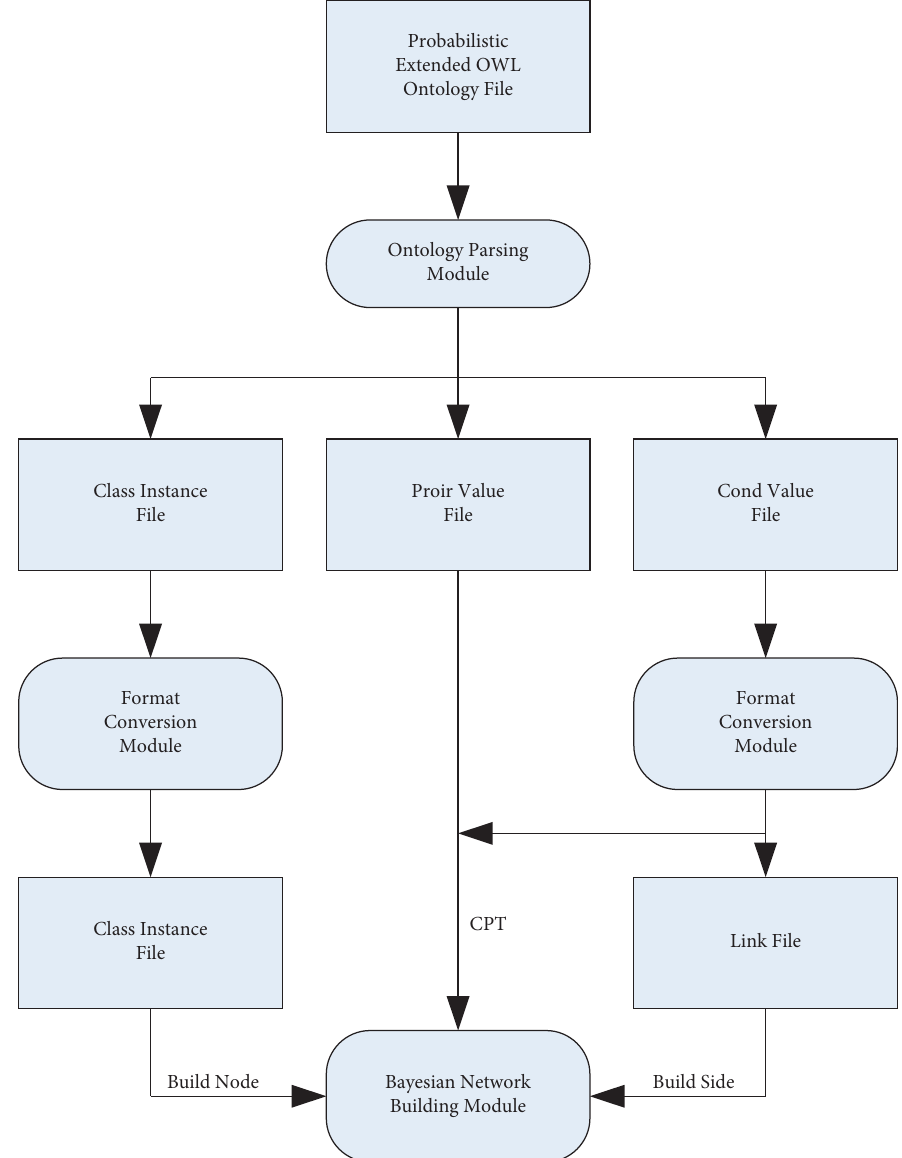
Figure 6: Flowchart of conversion of the situation awareness ontology into the Bayesian network.